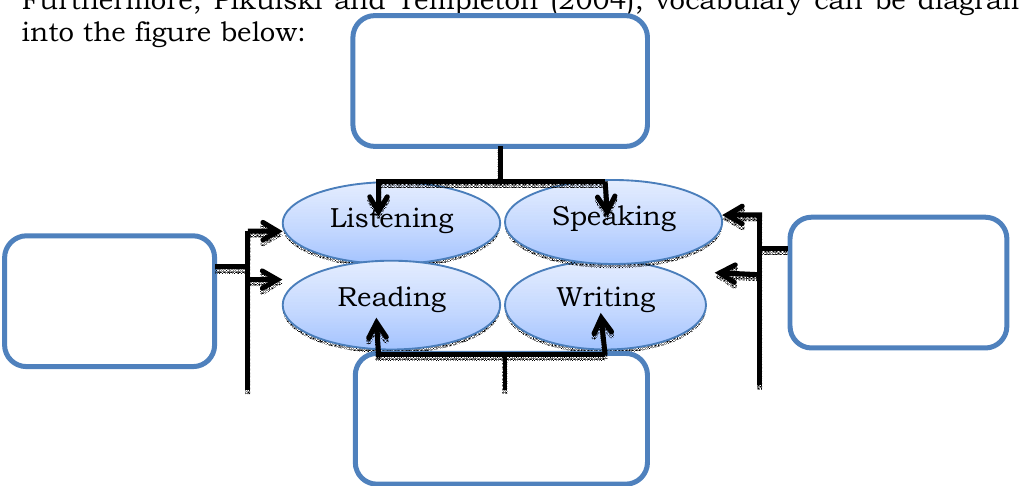
Figure 1. The relationship of the eight different